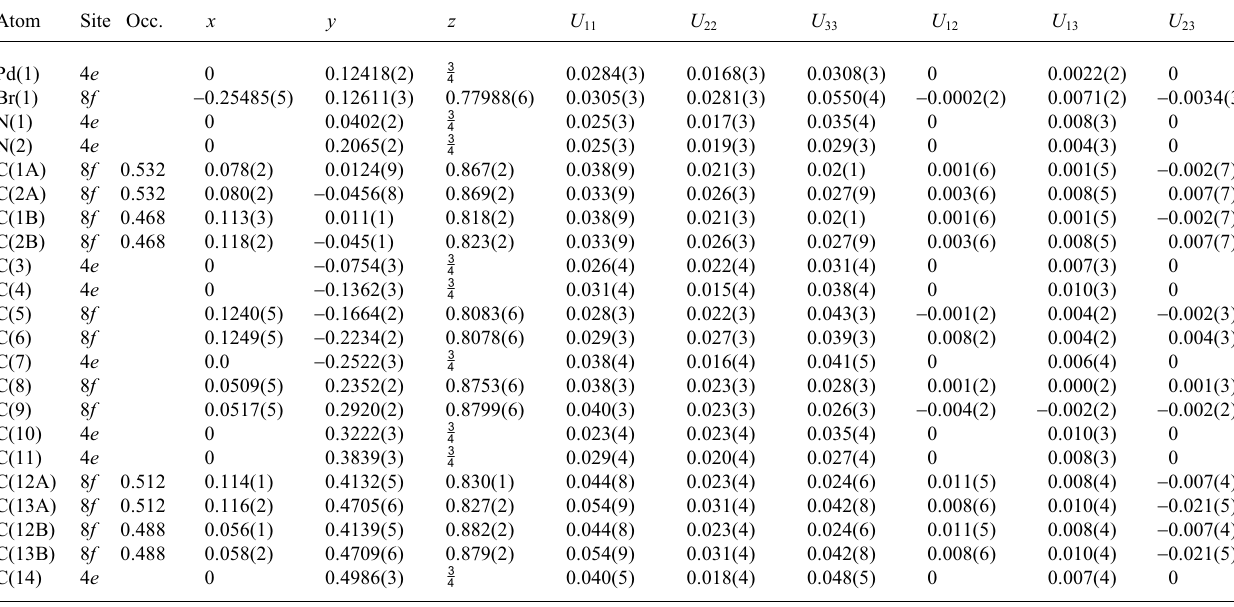
Table 3. Atomic coordinates and displacement parameters (in Å 2 ) . Atom Site